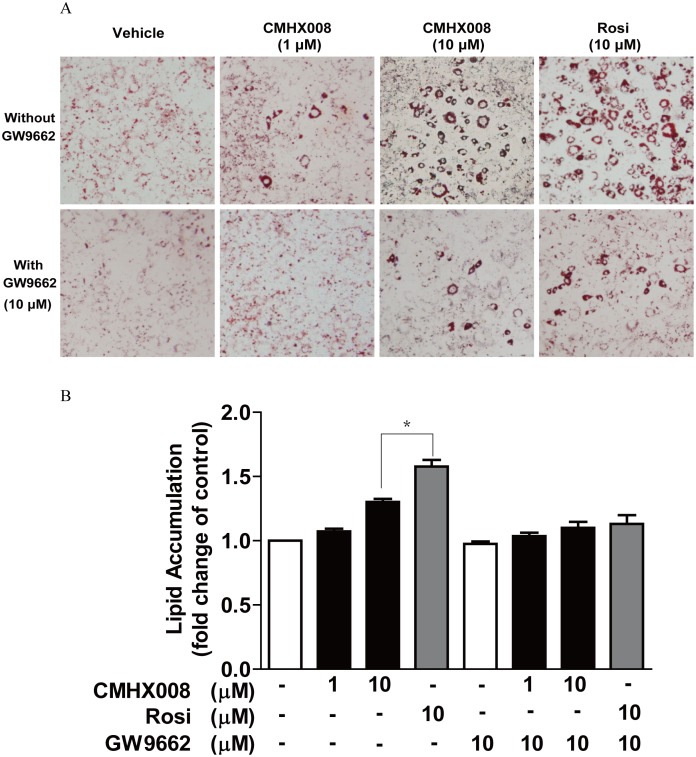
CMHX008 promotes 3T3-L1 preadipocytes differentiation and lipid accumulation.Post-confluent 3T3-L1 preadipocytes were incubated in differentiation medium for 2 days. The medium was changed to DMEM containing insulin and 10% FBS for another two days and then replaced again with fresh DMEM containing 10% FBS for another 3 days. Rosiglitazone and CMHX008, with or without GW9662, were administered at the initiation of differentiation and added with every medium change. At day 7, the differentiation cells were used for Oil Red O staining. A. The cells were fixed and stained with Oil Red O, and then stained adipocytes were photographed (100×); B. Stained cells were eluted with isopropyl alcohol and quantified at 490 nm. Data are the means ± S.E.M. from five experiments. *: P<0.05.